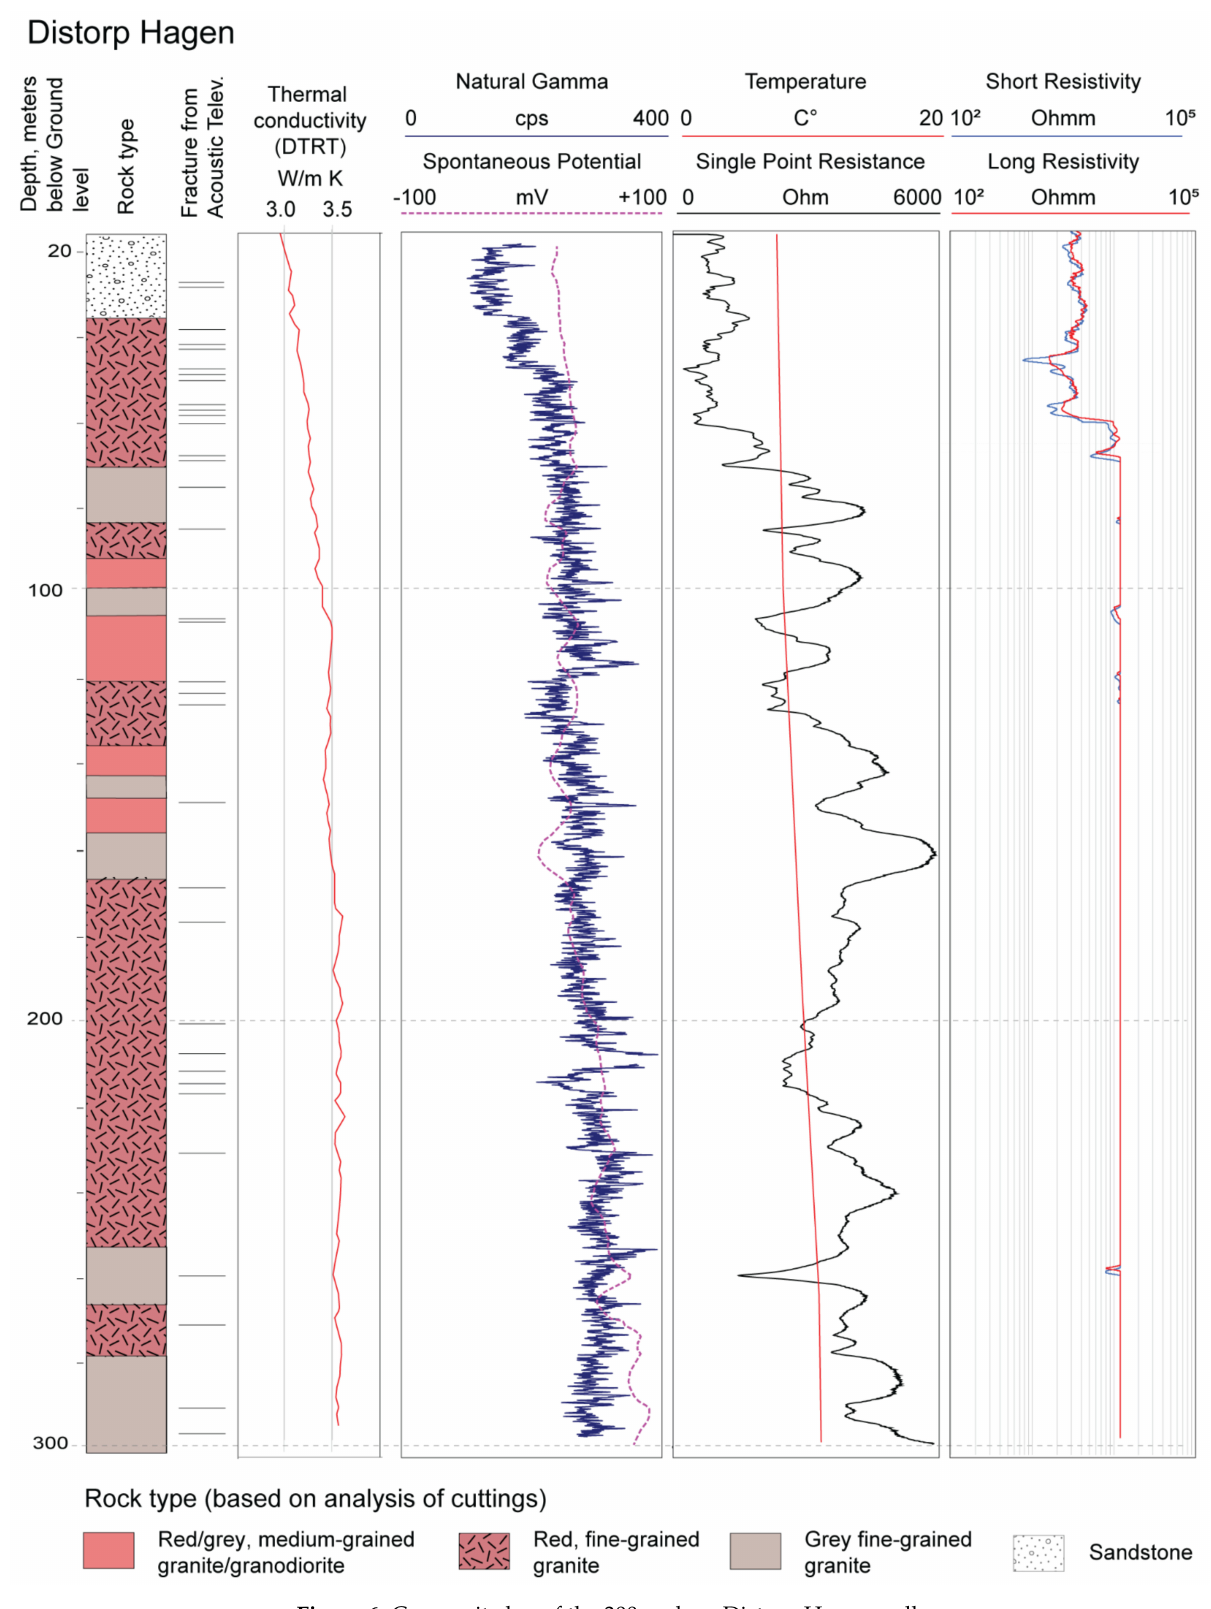
Figure 6. Composite log of the 300 m deep Distorp Hagen